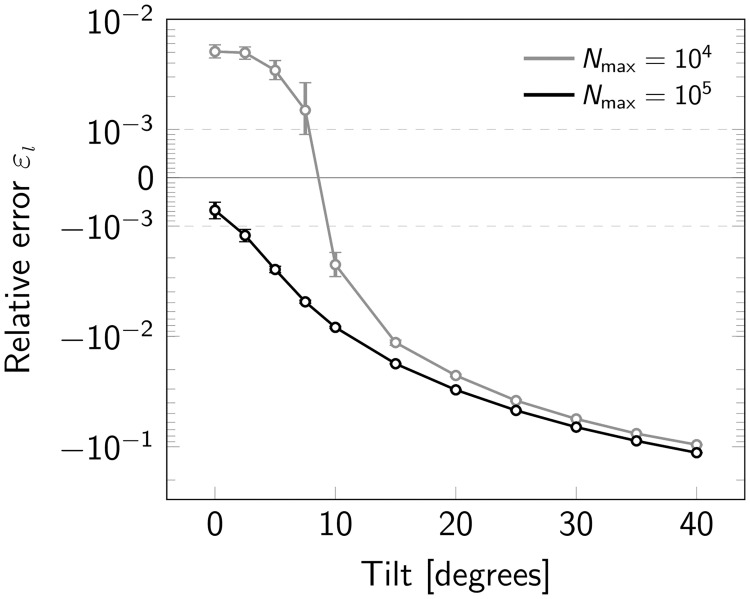
Influence of a tilt between the focal plane and the oligomerization plane.Relative error εl for varying tilt of the oligomerization plane shown in a symmetric logarithmic plot. Data was simulated both for a maximum number of photons Nmax = 104 (gray) and Nmax = 105 (black). Overestimation of oligomer sizes is indicated by positive, underestimation by negative relative errors. For each data point 500000 oligomers were simulated. The radius of the circumscribed circle of the oligomer was set to 4 nm. Error bars indicate the 95% confidence intervals.